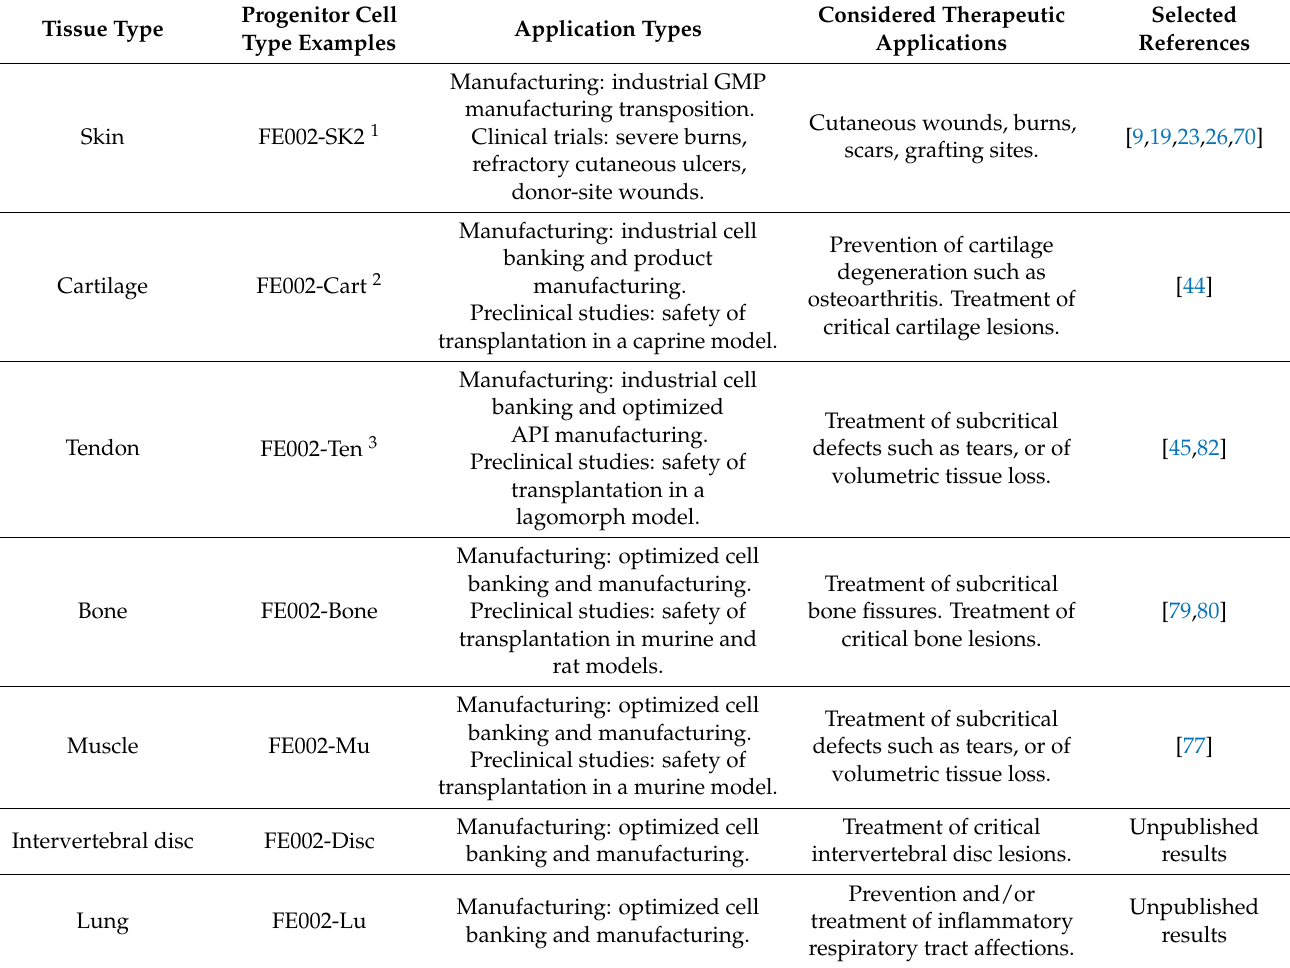
Table 4. Overview of the various tissue-specific homologous applications currently considered or investigated at clinical and preclinical stages under the Swiss progenitor cell transplantation program using human primary progenitor cells. Described and respective stages of scientific and technical or industrial development are effective as of December 2021. API, active pharmaceutical ingredient; GMP, good manufacturing